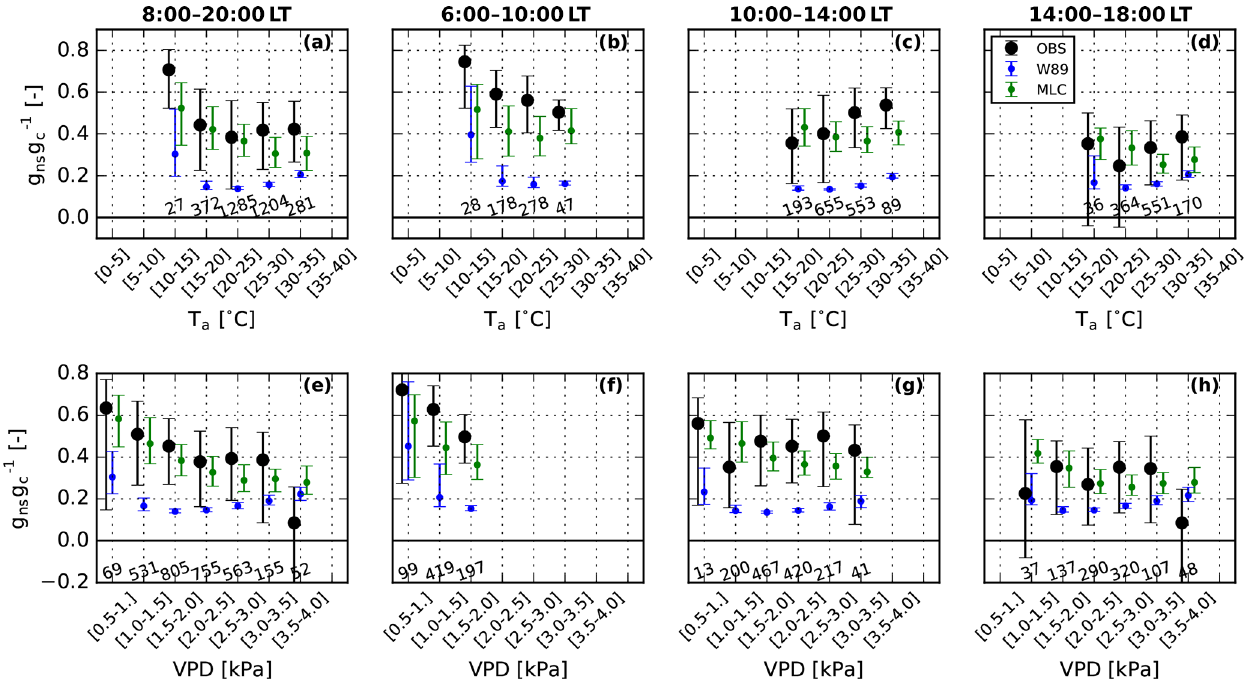
− 1 Figure 7. Non-stomatal ozone removal fraction g ns g c binned by air temperature (a–d) and vapor pressure deficit (e–h) during June– September 2013–2015 at Ispra. Black dots and whiskers show g ns g − 1 c from observations and simulations by W89 (blue points and whiskers) and MLC-CHEM (green points and whiskers). Dots and whiskers display the median and interquartile range per bin, respectively, and the number of observations in the bin is displayed at the bottom of the panels. Each column corresponds to a different time period in the diurnal cycle, namely all day (08:00–20:00LT; a, e ), morning (06:00–10:00LT; b, f ), midday (10:00–14:00LT; c, g ), and afternoon (14:00–18:00LT; d, h ). Dots and whiskers are only shown if the number of samples in the bin exceeds